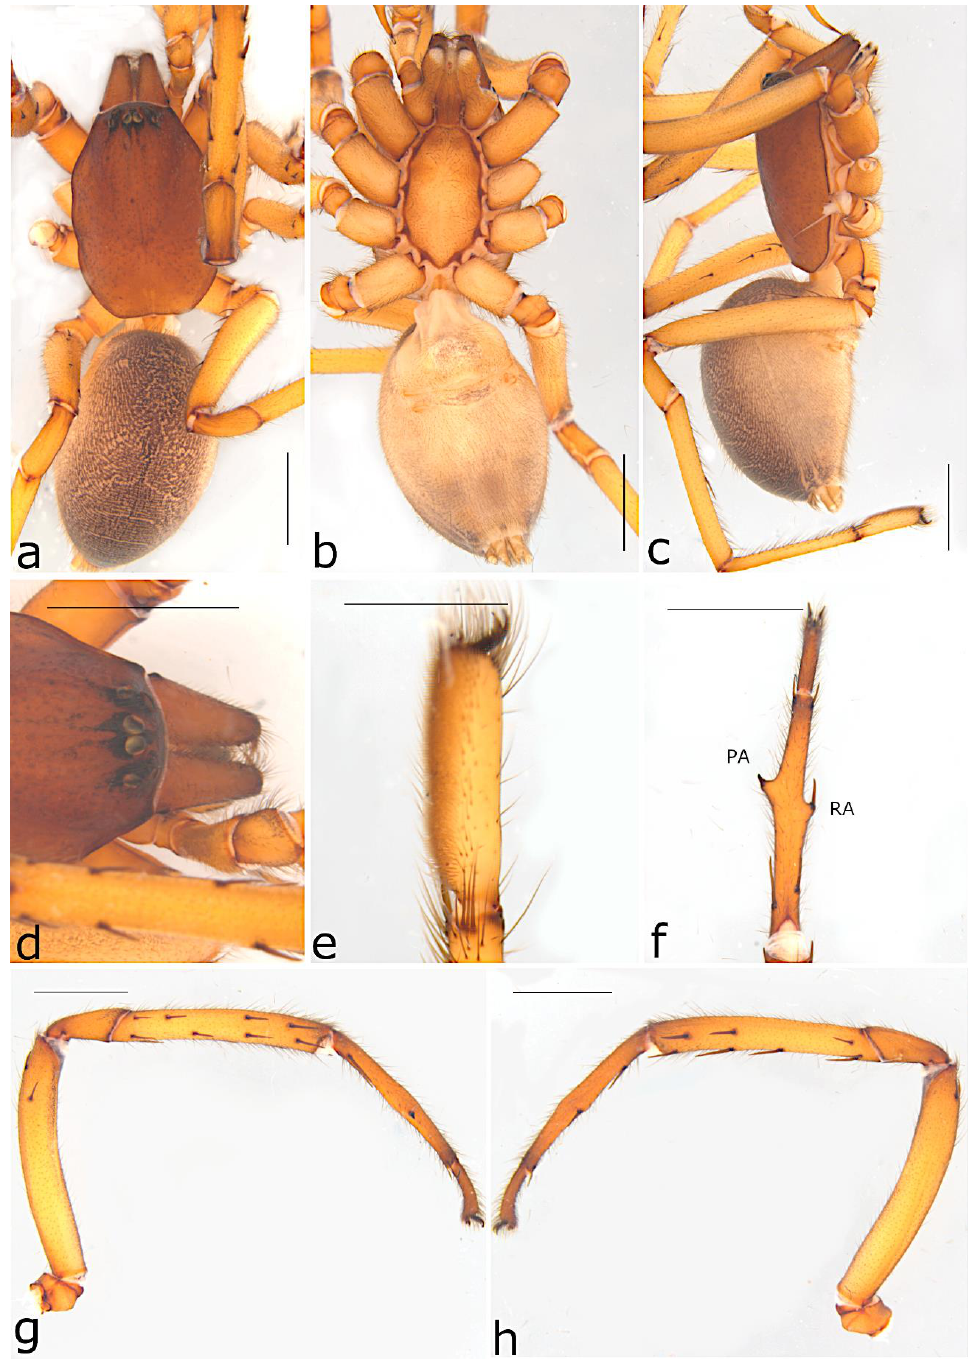
Figure 69. Ariadna valida sp. nov. ♂ holotype (SAMA NN10579) from near Illintjitja (SA): ( a ) habitus, dorsal view; ( b ) same, ventral view; ( c ) same, lateral view; ( d ) eyes, dorsal view; ( e ) left metatarsus IV, preening comb, retrolateral view; ( f ) left leg I, ventral view; ( g ) same, prolateral view; ( h ) same, retrolateral view. Scale bars ( a – d ) = 2 mm, ( e ) = 1 mm and ( f – h ) = 2 mm.